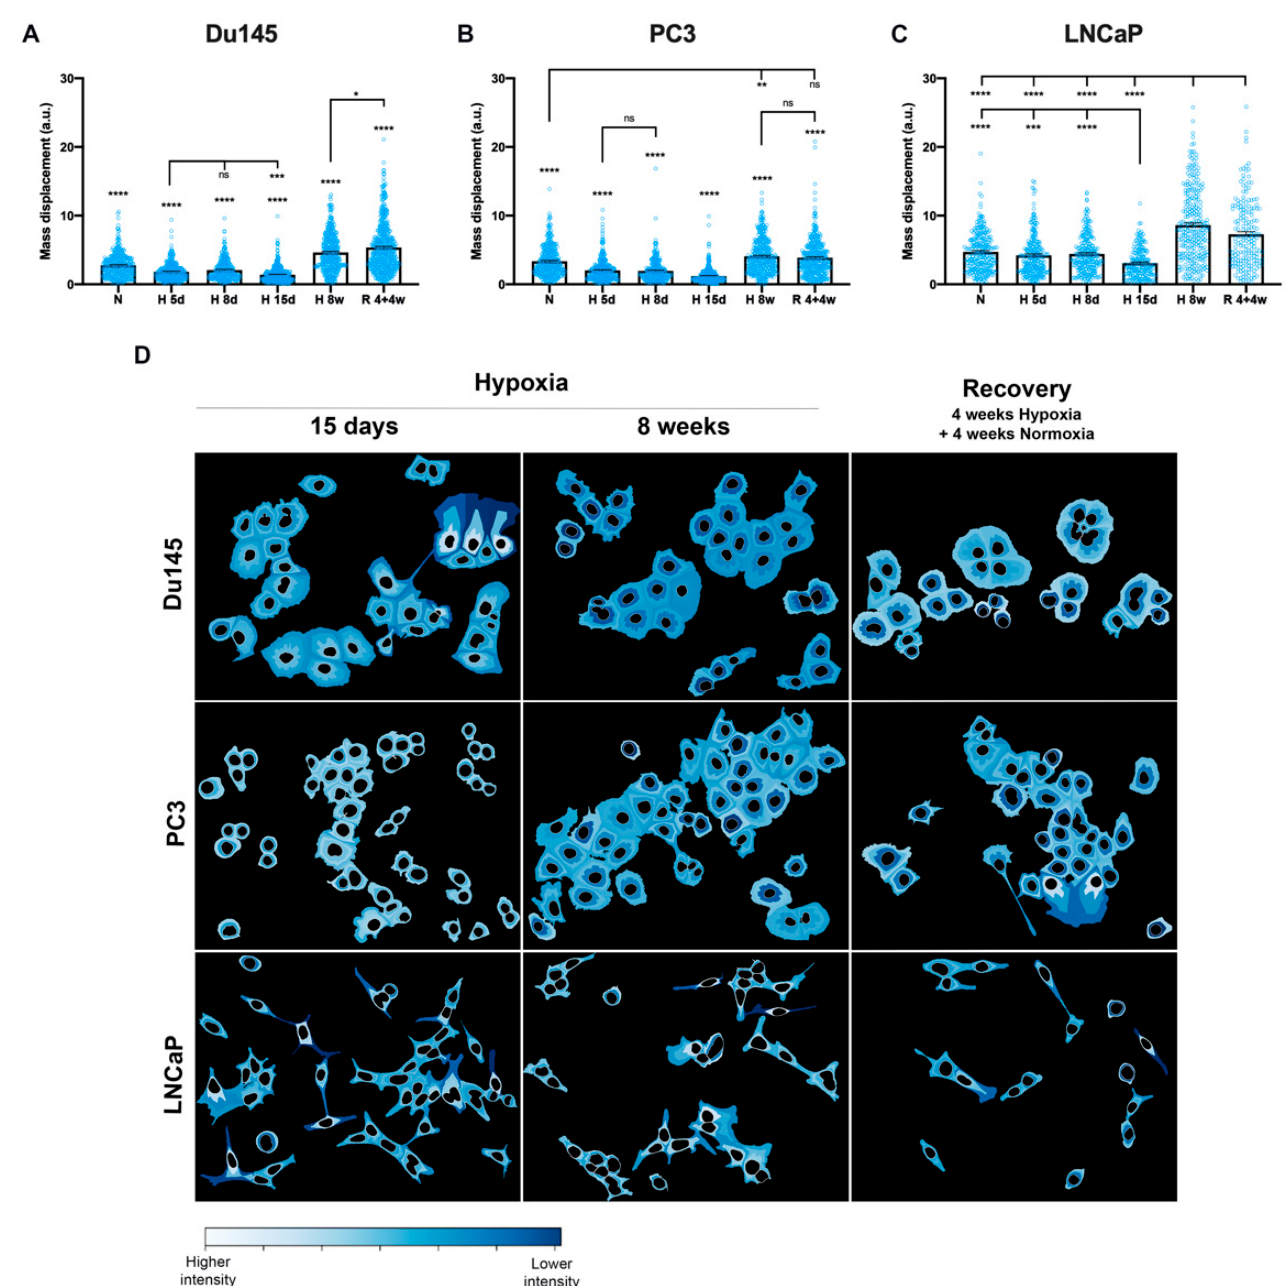
Figure 5. AQP3 cytoplasmic distribution. Mass displacement for AQP3 cytoplasmic labeling is shown for ( A ) Du145, ( B ) PC3 and ( C ) LNCaP cells. ( D ) Fraction of distance graphical representation of AQP3 intensity in the cytoplasmic compartment, using 4 bins. Scale of intensity is normalized for each image individually, for its maximum and minimum intensity, with a lighter color representing the highest intensity. Data from CellProfiler, from cells under acute hypoxia (5 d, 8 d, 15 d—days 5, 8 and 15), chronic hypoxia (8 w—8 weeks) and recovery (4 + 4 w—4 weeks hypoxia + 4 weeks normoxia). Each condition has, on average, 278 (Du145), 319 (PC3) and 217 (LNCaP) individual cells and data are shown as mean ± SEM. **** p < 0.0001, *** p < 0.001, ** p < 0.01, * p < 0.05, ns—not significant.